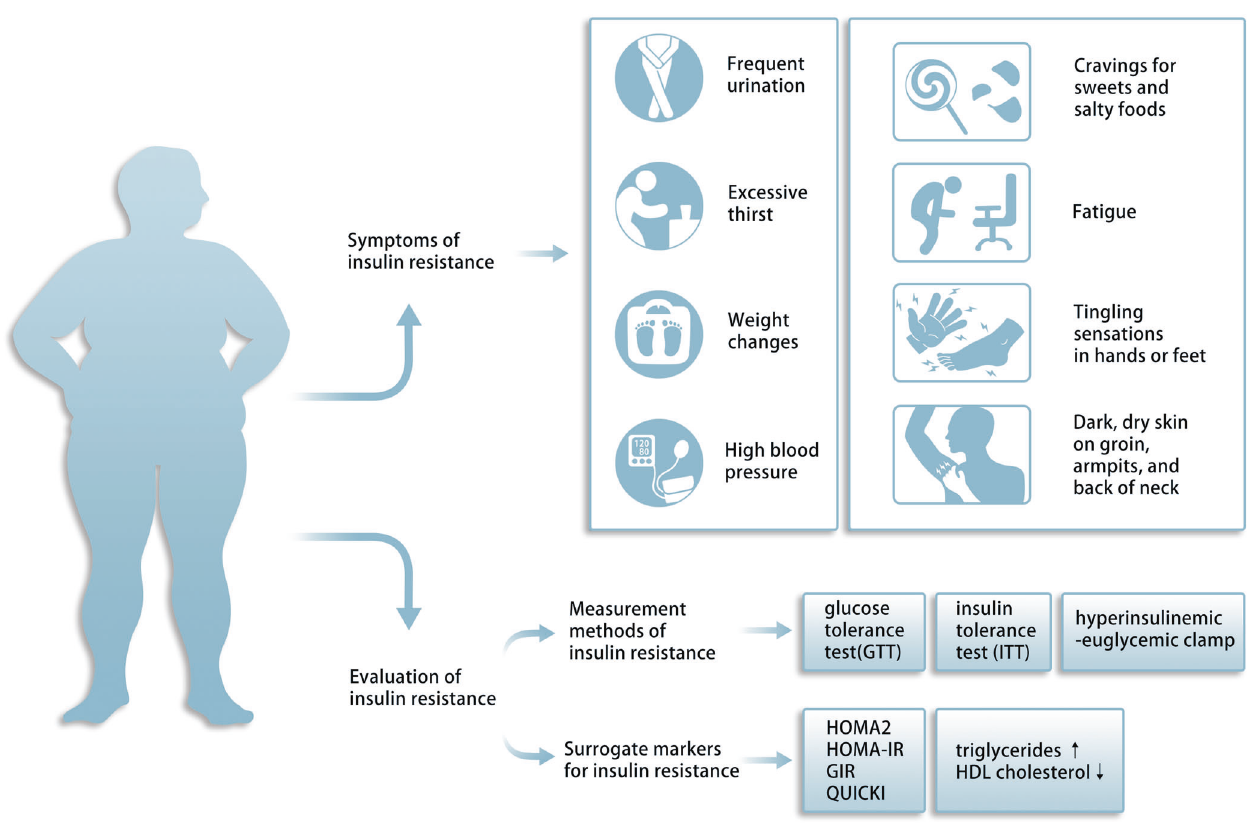
Fig. 5 Ex vivo diagnosis methods for insulin resistance